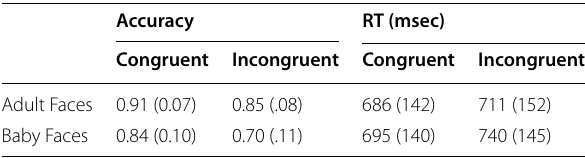
Table 7 Group-level performance in the face composite task in Experiment 2